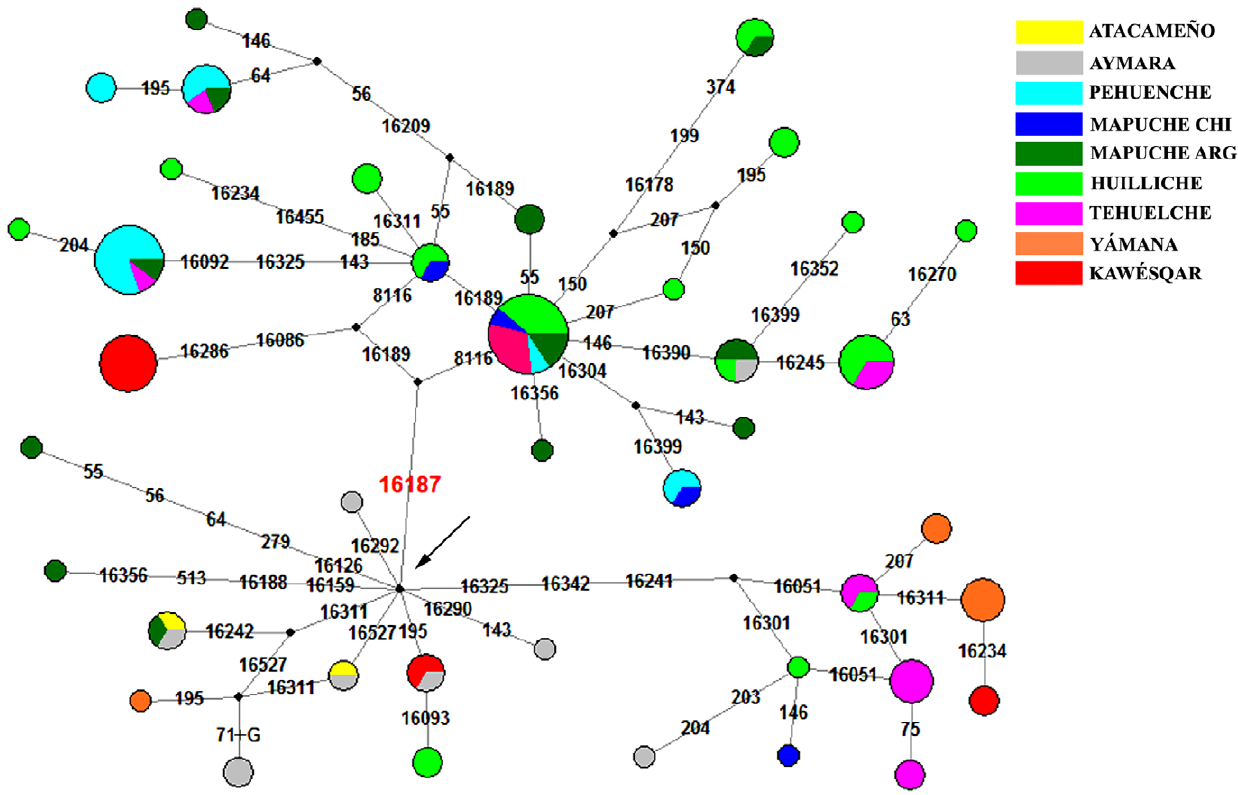
Figure 2. Network for the D haplogroup. The arrow shows the D1 nodal, characterized by rCRS differences at 16223-16325-16362-073-263- 315 + C-489. Besides the D1 haplotypes, the new lineage D1g is represented here, characterized by the mutation 16187T plus D1 core, and the D4h3a lineages, characterized by 16342 and 16241 polymorphisms.